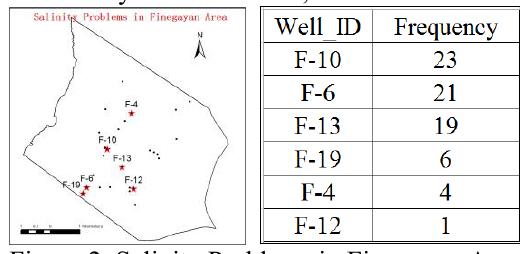
Figure 2. Salinity Problems in Finegayan Area